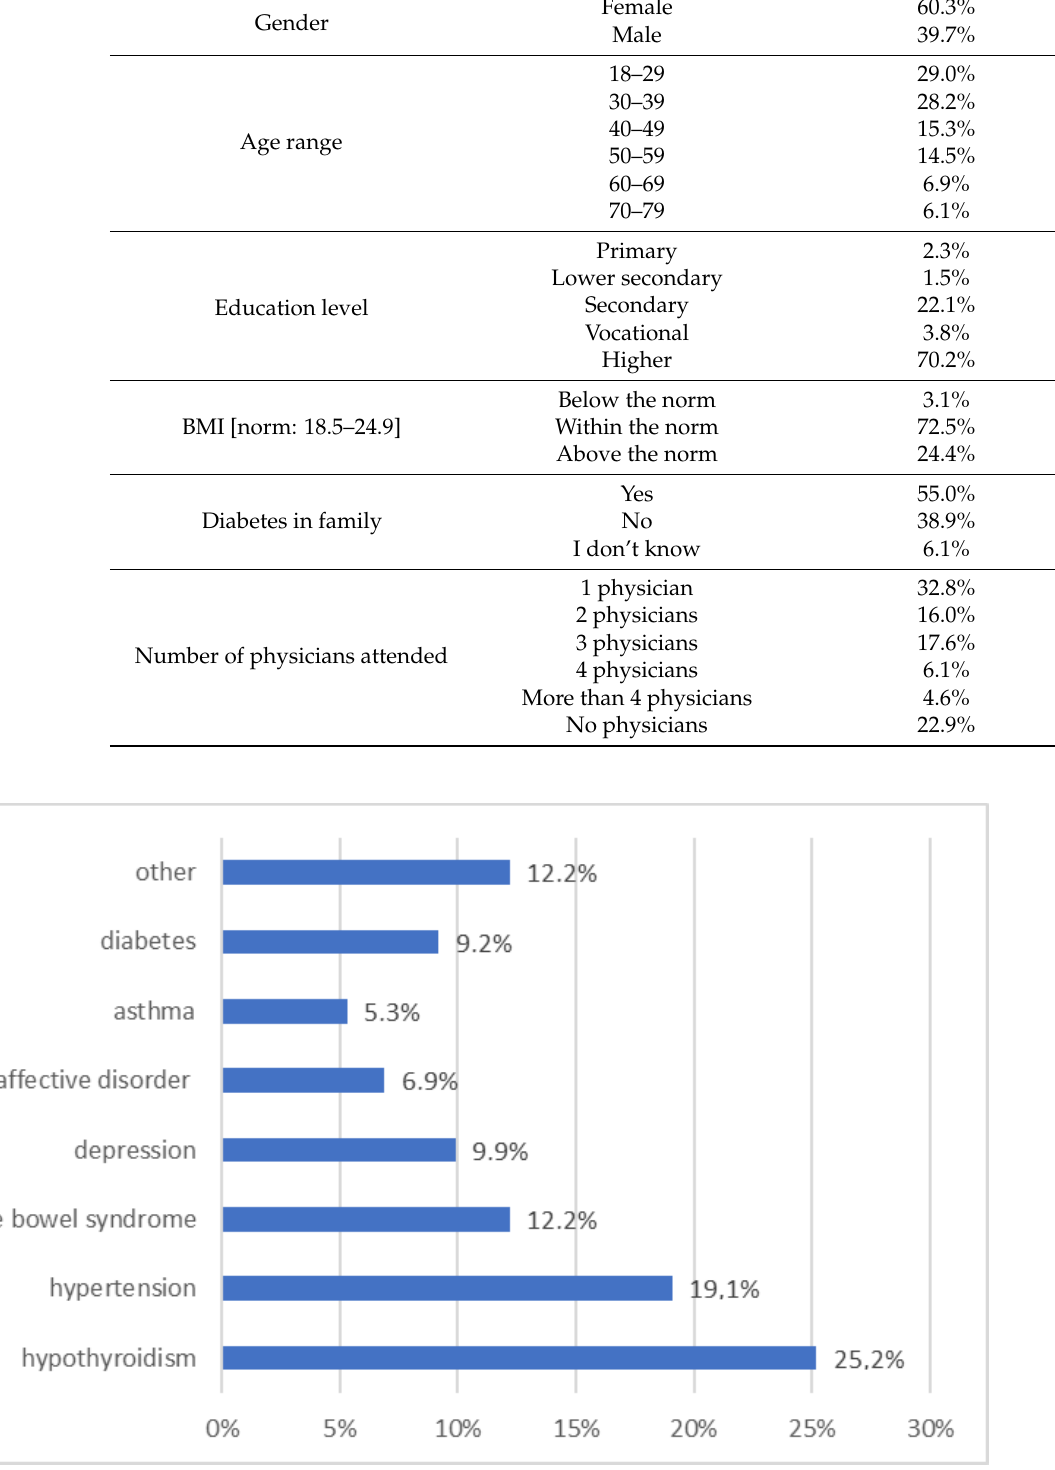
Figure 2. Diseases declared by the surveyed patients ( n = 53).